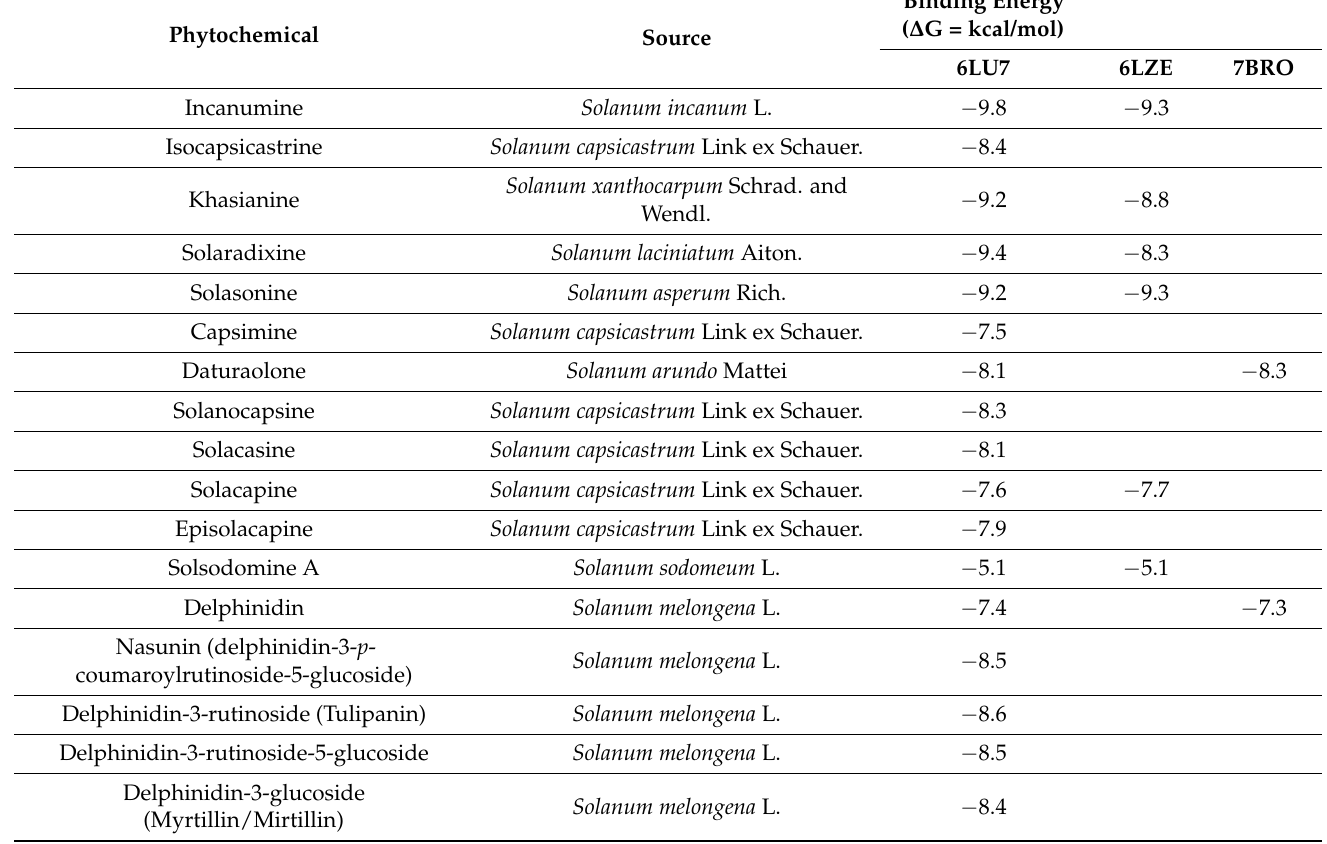
Table 1. Predicted binding energy in molecular docking studies of some Solanaceae family phy- tochemicals to Mpro (without attached inhibitor) of SARS-CoV-2. Additionally presented are the binding energies of several drugs used against COVID-19 and flavonoids reported to bind to Mpro in in silico studies. Note that three reported crystalline structures of Mpro were used, namely 6LU7, 6LZE, and 7BRO for comparison of results of binding